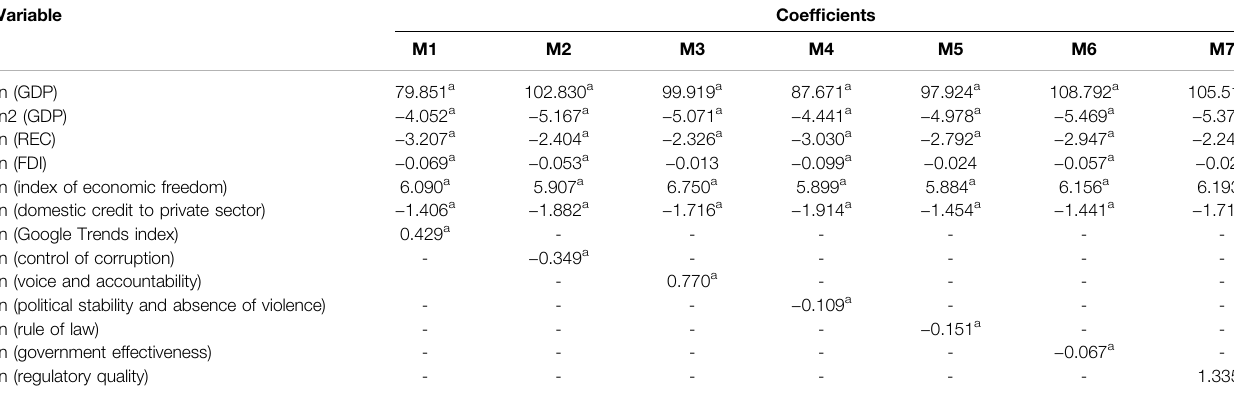
TABLE 5 | Panel DOLS models to explain GHG emissions in the 10 CEE countries (2006 – 2019).